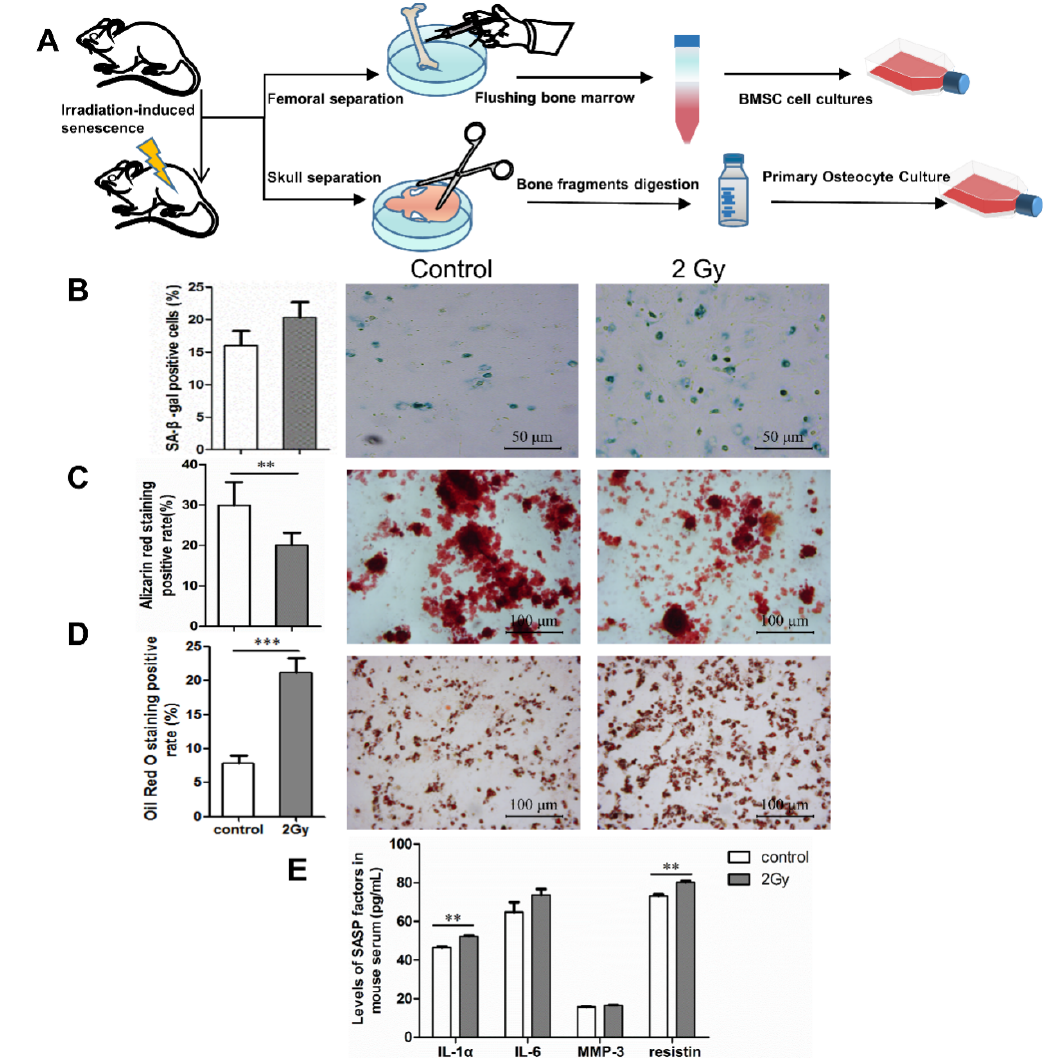
Figure 6. Effect of whole-body irradiation on osteocytes and bone formation. ( A ) Pattern diagram of the experiment. ( B ) Identification of senescence-associated β -galactosidase (SA- β -gal) expression in primary osteocytes extracted from skull bones of mice. Representative images (blue represents SA- β -gal-positive cells) and quantification of SA- β -gal-positive osteocytes from three independent experiments; magnification = ×200, n = 3. ( C , D ) Effect of whole-body irradiation on bone formation in mice after 7 days. Osteogenic and adipogenic differentiation were induced in vitro by primary BMSCs from mice. Representative images and quantitative analysis of mineralized nodule area and lipid droplet formation are shown; magnification = ×100, n = 6. ( E ) Changes in SASP components in mice serum after 7 days post irradiation; n = 3. Results are expressed as mean ± SD (** p < 0.01; *** p < 0.001 vs. control).